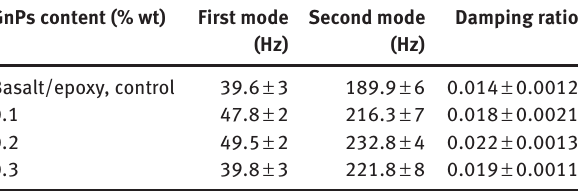
Table 2: Vibration test results. GnPs content (%